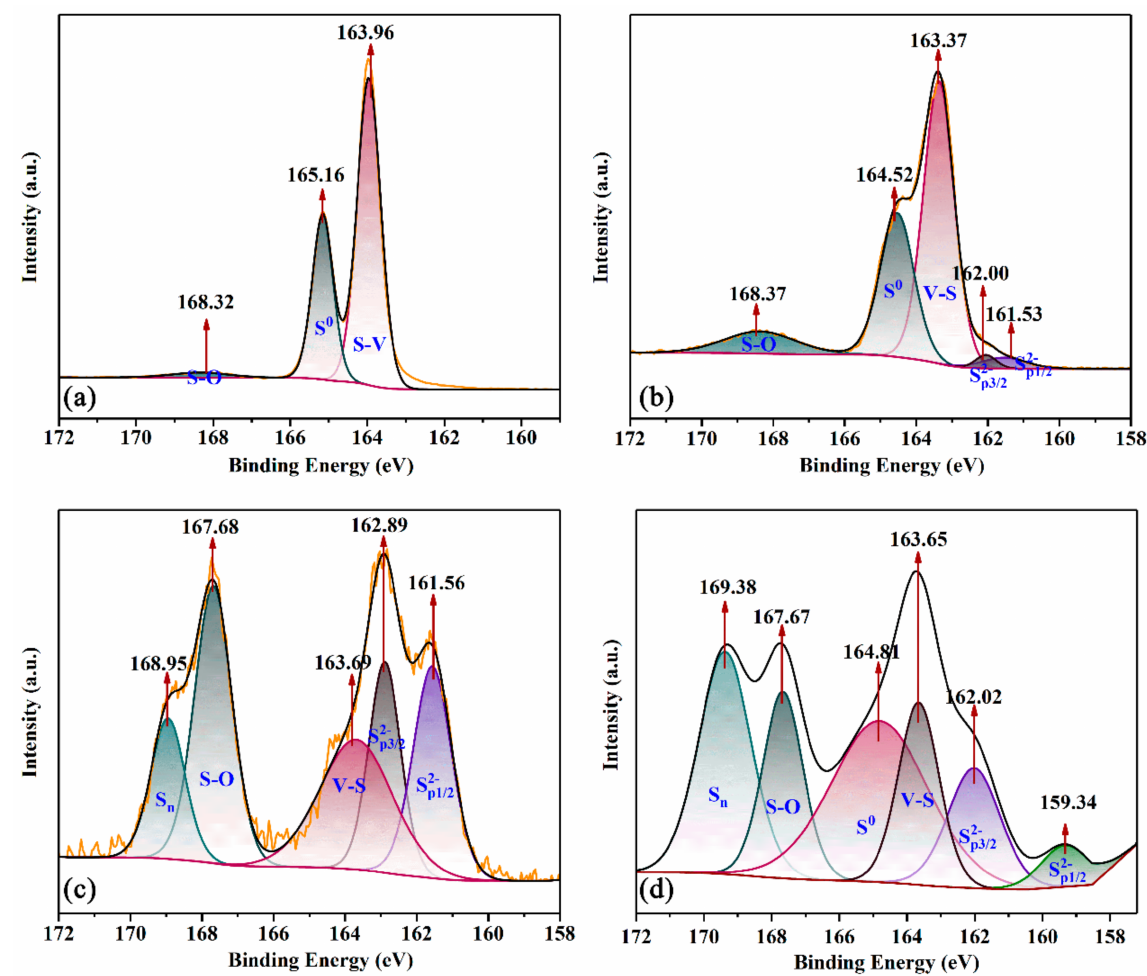
Figure 6. The XPS spectra from optimum amount of NaVO 3 at ( a ) 1 h; ( b ) 4 h; ( c ) 10 h; ( d ) 11